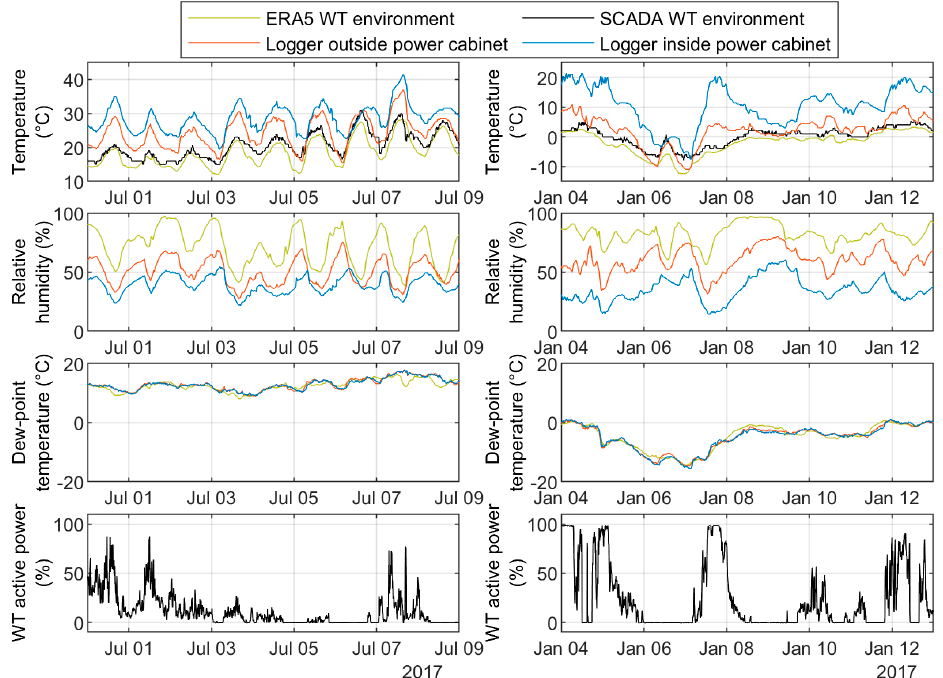
Figure 6. Segments of the logger, SCADA and ERA5 data presented in Figure 5 from an onshore wind turbine in Germany with air-cooled converter located in the tower base; example time series from summer ( left ) and winter ( right ).